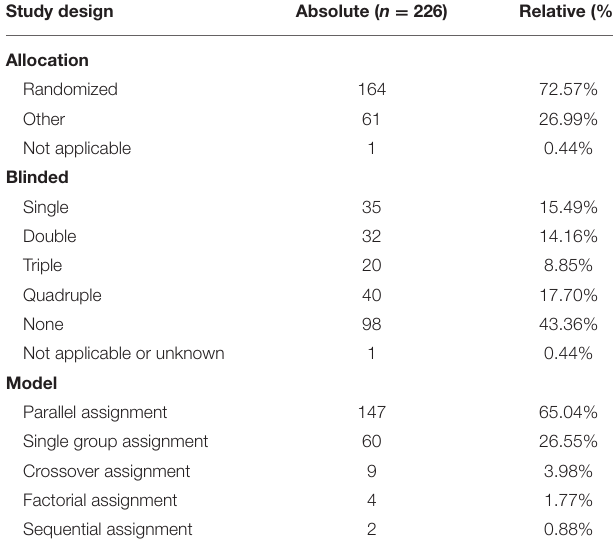
TABLE 5 | Study design of interventional